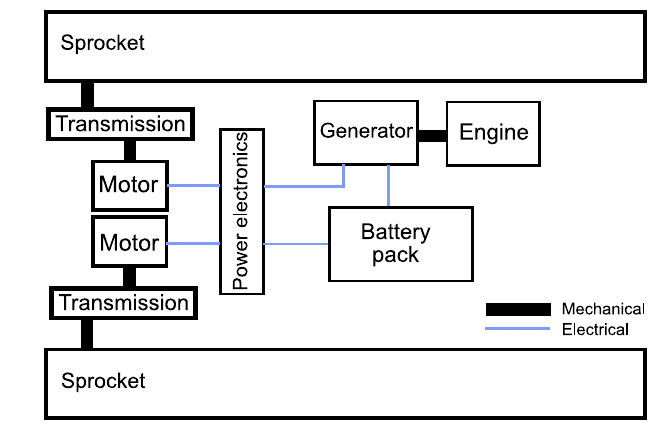
Figure 1 – Proposed powertrain